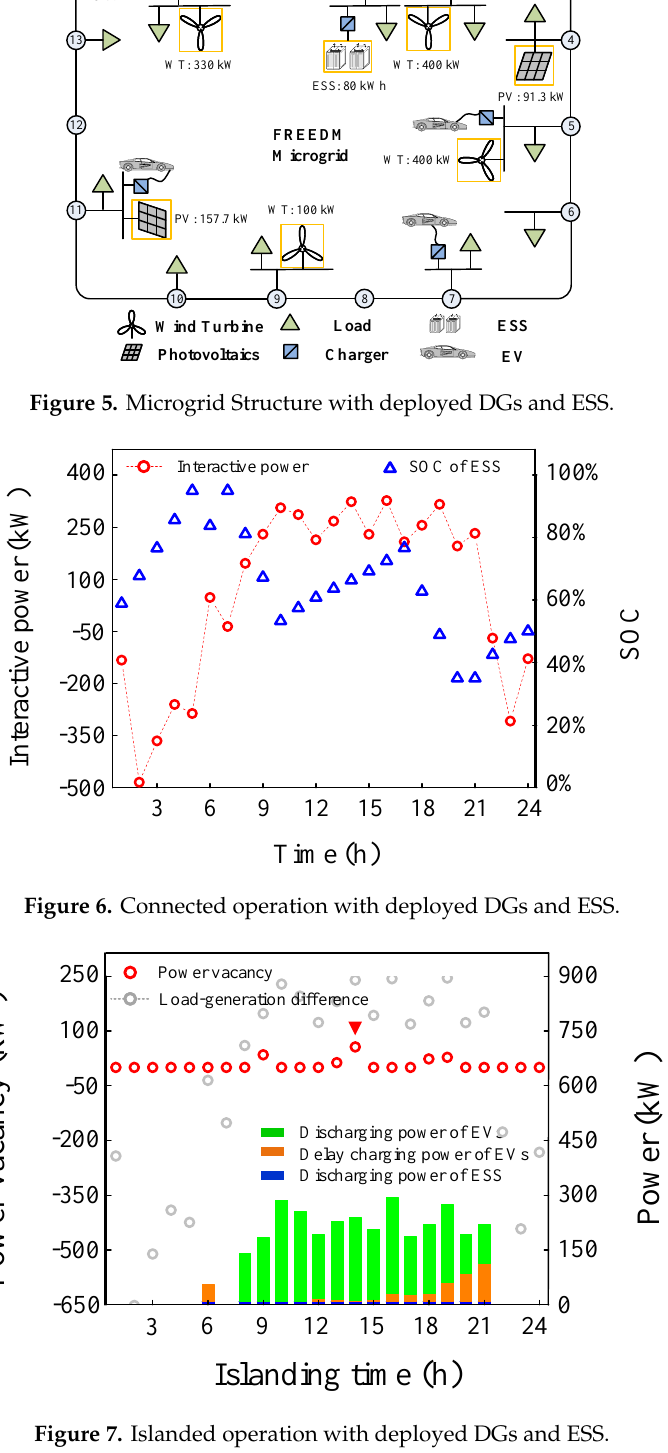
Figure 7. Islanded operation with deployed DGs and ESS.